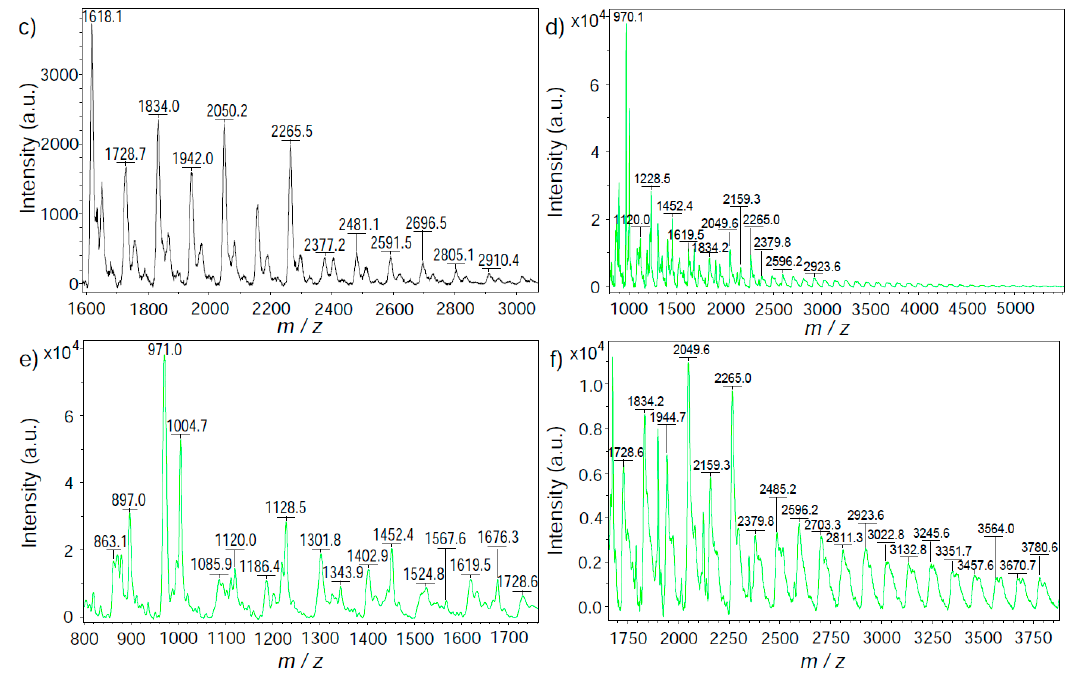
Figure 4. MALDI/TOF mass spectra of tetrahydrofuran (THF)-soluble part of PBT salts prepared with ( a – c ) an I 2 /BT molar ratio of 1.5 and an initial BT concentration of 50 mmol L − 1 , and ( d – f ) an H 2 O 2 /BT molar ratio of 3.53 and an initial BT concentration of 58.25 mmol L − 1 in ethanol at 25 °C for 24 h.